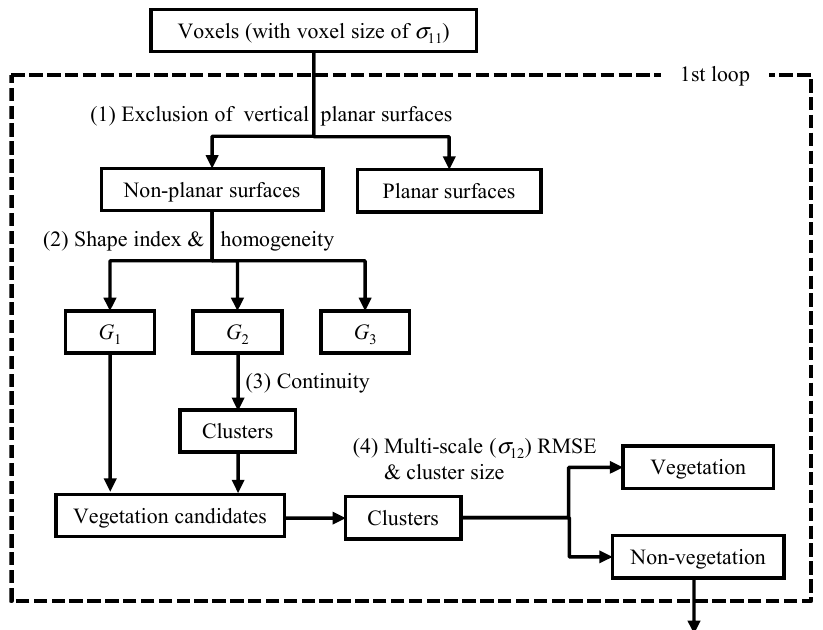
Figure 5. Flowchart of the method for extracting point clouds of vegetation. G 1 , G 2 and G 3 denote groups of vegetation, ambiguous voxels (vegetation and non-vegetation), and non-vegetation, respectively. σ ij denotes voxel size for the j -th processing in the i -th loop.